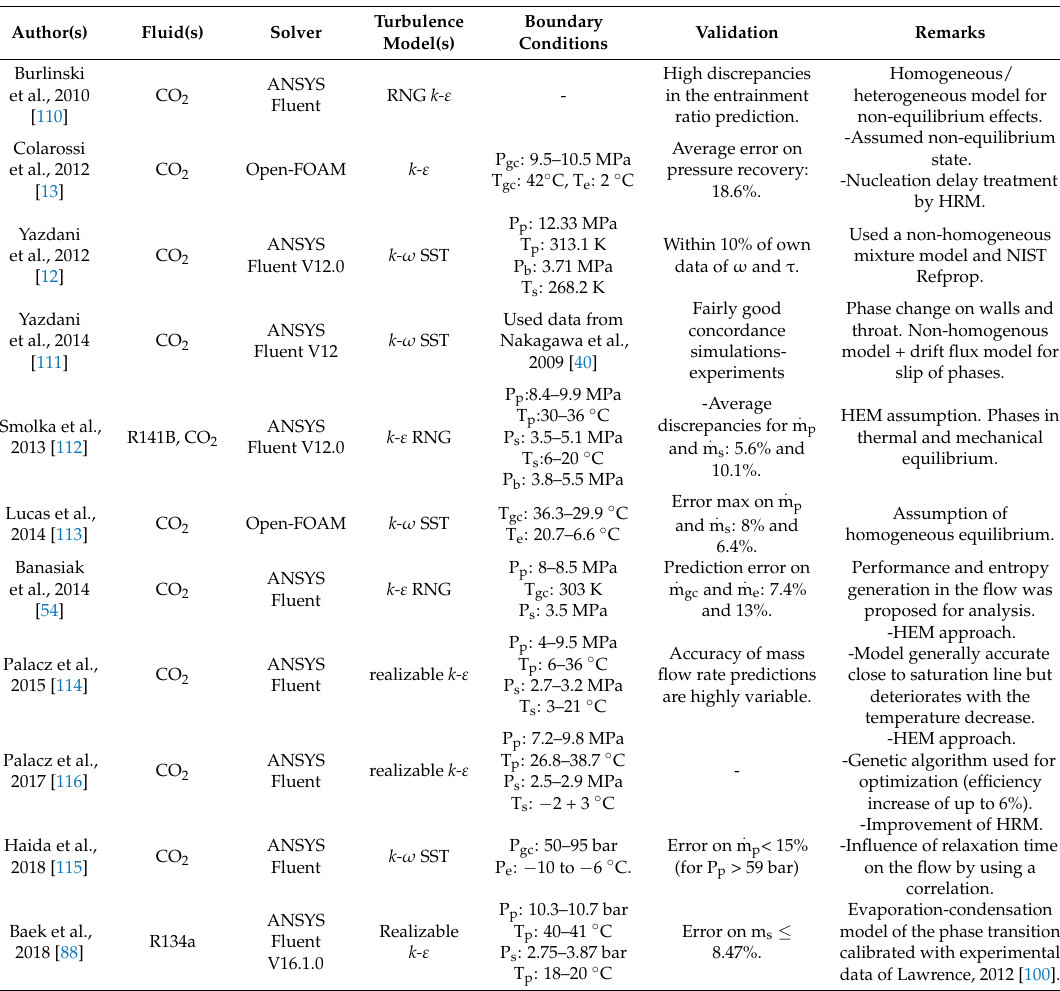
Table 2. Two-phase ejector computational fluid dynamics (CFD)